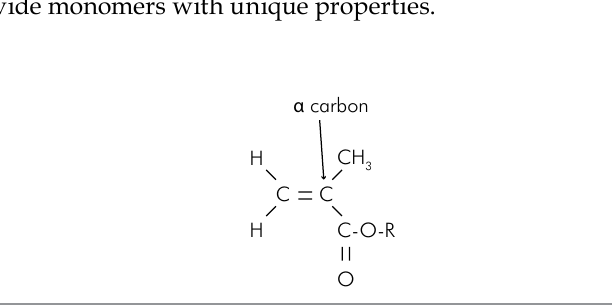
Figure 1. Chemical structure of a methacrylate-based